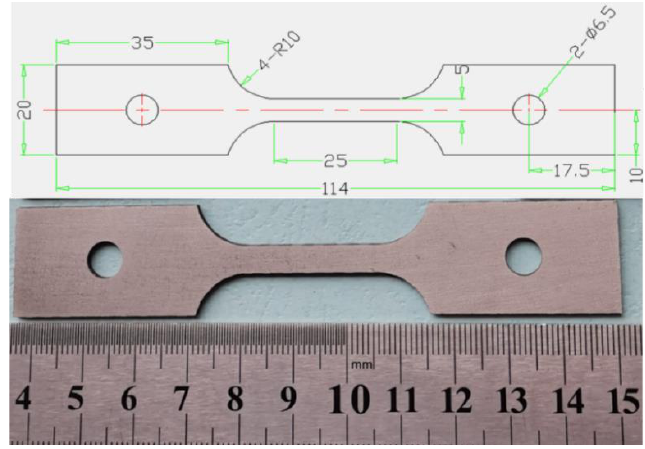
Figure 2. The tensile specimen of the GH3625